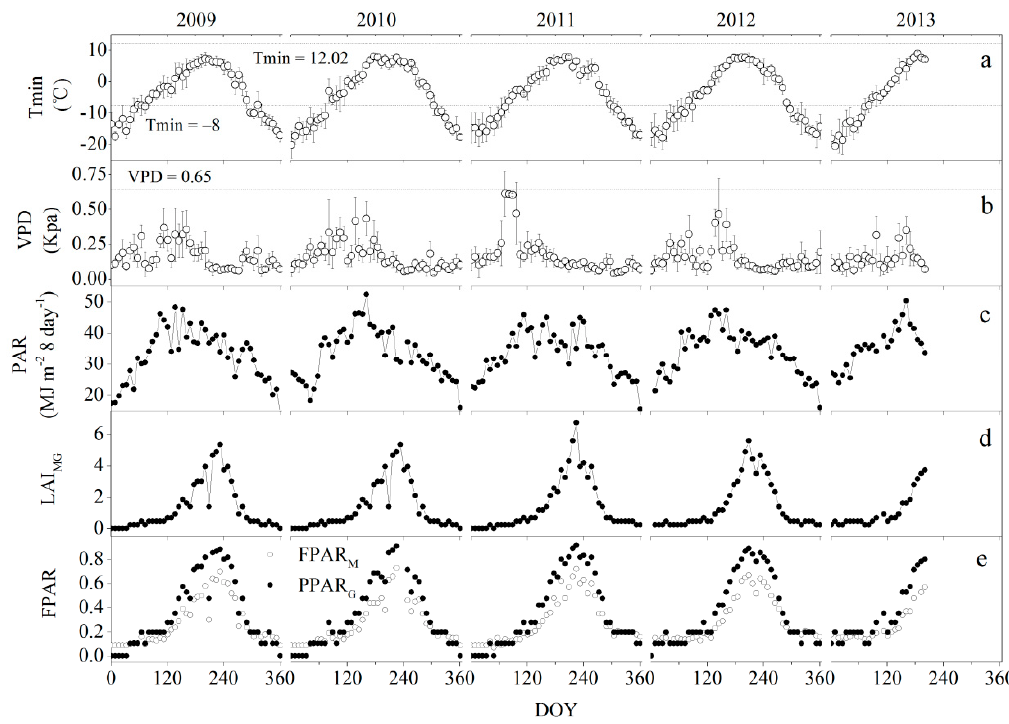
Figure 1. Seasonal variation of ground meteorological measurements data and the FPAR from 2009 to 2013. All data are integrated into 8-day time step and showed with the first day of each 8-day interval, the error bars in ( a ) and ( b ) are standard deviation for corresponding mean values. ( a ), Tmin is the daily minimum temperature; ( b ), VPD is the daily vapor pressure deficit; ( c ), PAR is photosynthetically active radiation; ( d ), the consecutive LAI MG is derived from linear regression between ground LAI G measurements and MODIS LAI (LAI M ) in LAI G measurement days ( n = 23); ( e ), FPAR M is directly obtained from MODIS products, while FPARG is calculated from LAI G in e based on Beer-Lambert law. The consecutive LAI MG was stimulated from the linear regression between the consecutive